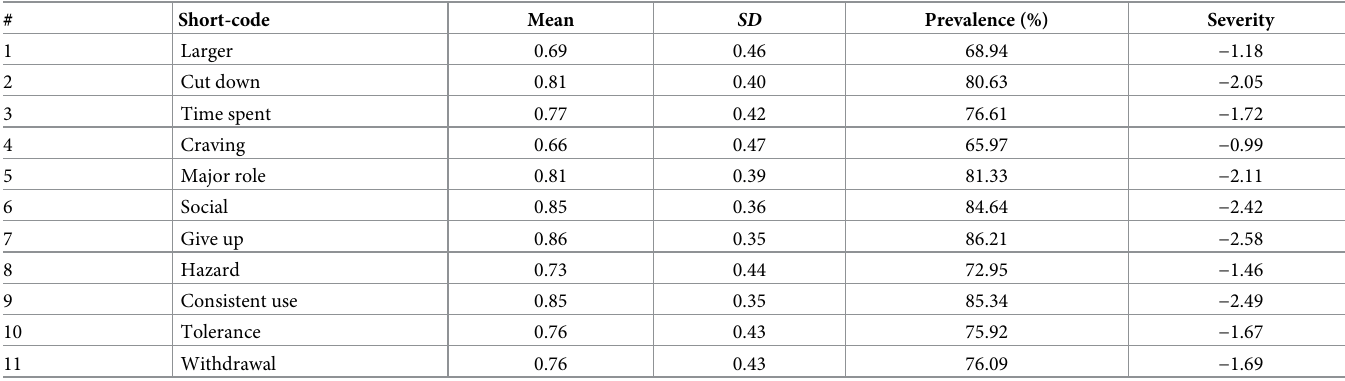
“Severity” refers to the item difficulty parameter by Rasch model without any person covariates.